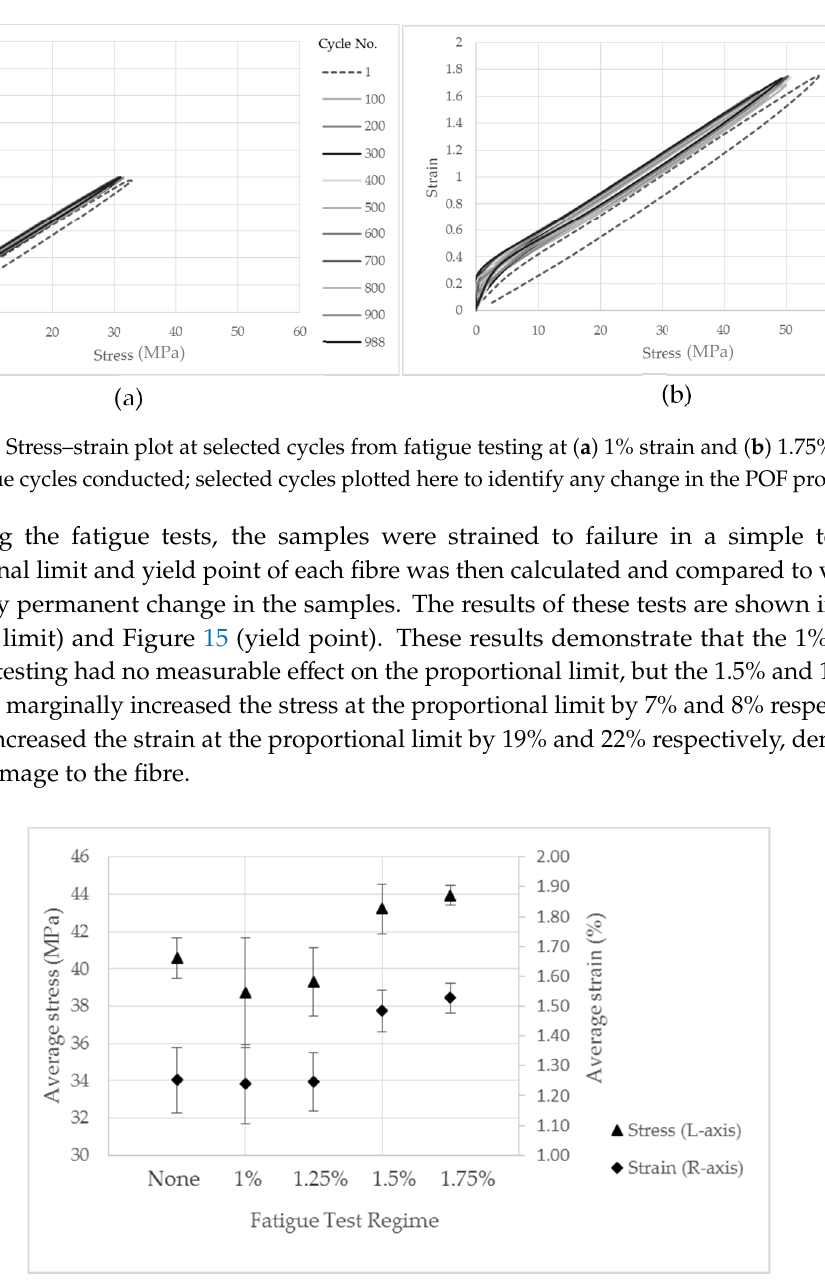
Figure 14. Stress and strain values calculated at the proportional limit during a tensile test following a 1000 cycle fatigue testing regime at the specified strain. Datapoints are the average of three test samples and error bars represent sample standard deviation.